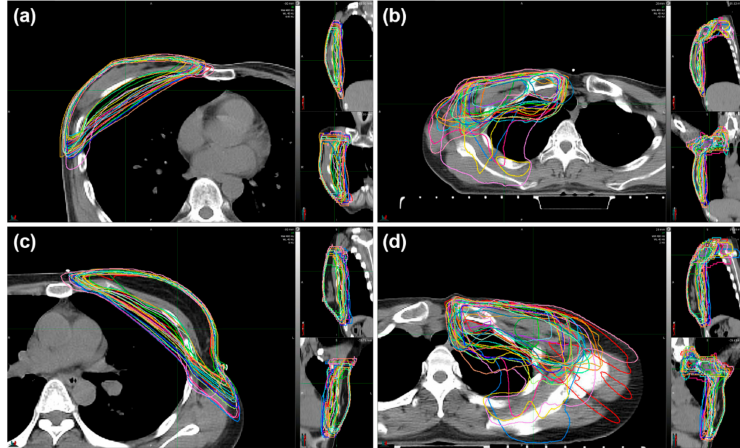
Figure 1. Isodose contours representing 90% of the prescribed dose in each institution for the cases of ( a ) WBI arm in Case A, ( b ) WBI + RNI arm in Case A, ( c ) WBI arm in Case S, and ( d ) WBI + RNI arm in Case S. Abbreviations: WBI, whole-breast irradiation; WBI + RNI, whole-breast irradiation plus regional nodal